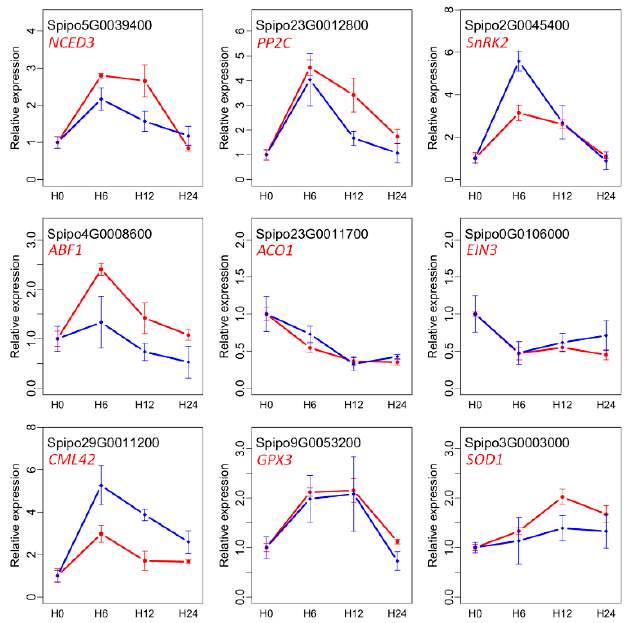
Figure 8. Validation of gene expression patterns using qRT-PCR. Values are presented as mean ± SD of three independent replicates. Blue and red lines represent the expression values from qRT-PCR and RNA-seq, respectively.